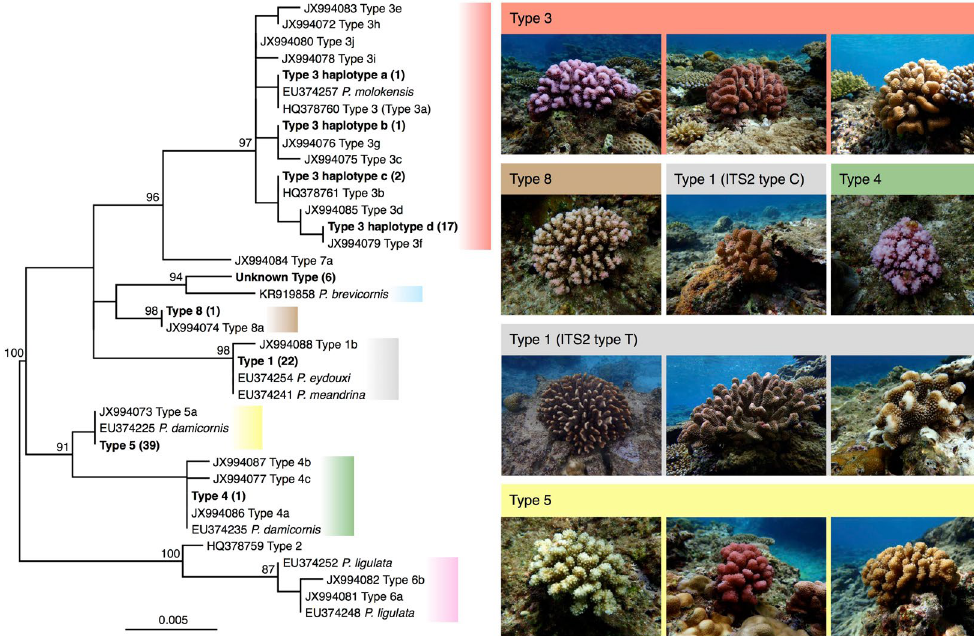
Figure 1. Maximum likelihood phylogenetic tree based on the mtORF comparing the variety of haplotypes with the variety of morphological types of Pocillopora . Immense diversity is evident even within lineages in the Ryukyu Archipelago. Boldface indicates haplotypes that were isolated during this study (GenBank accession No. LC222444–LC222452). Values in parentheses indicate the number of colonies collected from two sites at Miyako Island. Values in the tree indicate maximum likelihood bootstrapping (over 75%). Cluster colors correspond to genetic lineages reported by Schmidt-Roach et al . 12